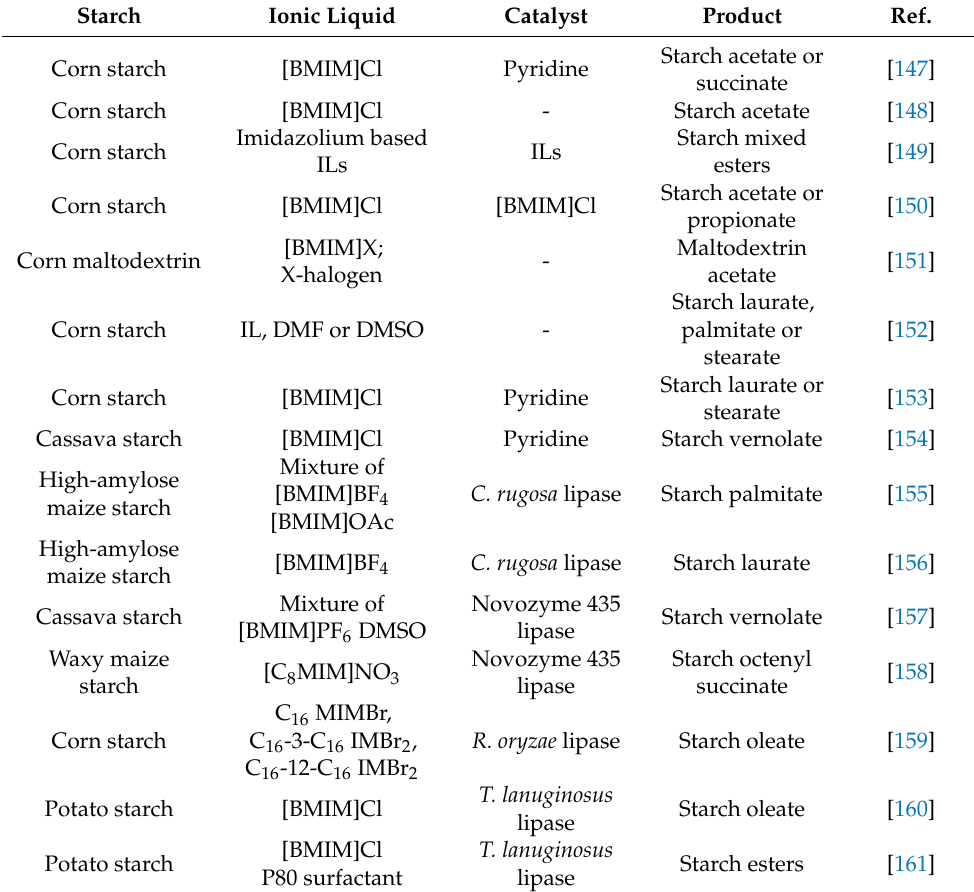
Table 3. Esterification of starch in ionic liquids (ILs).